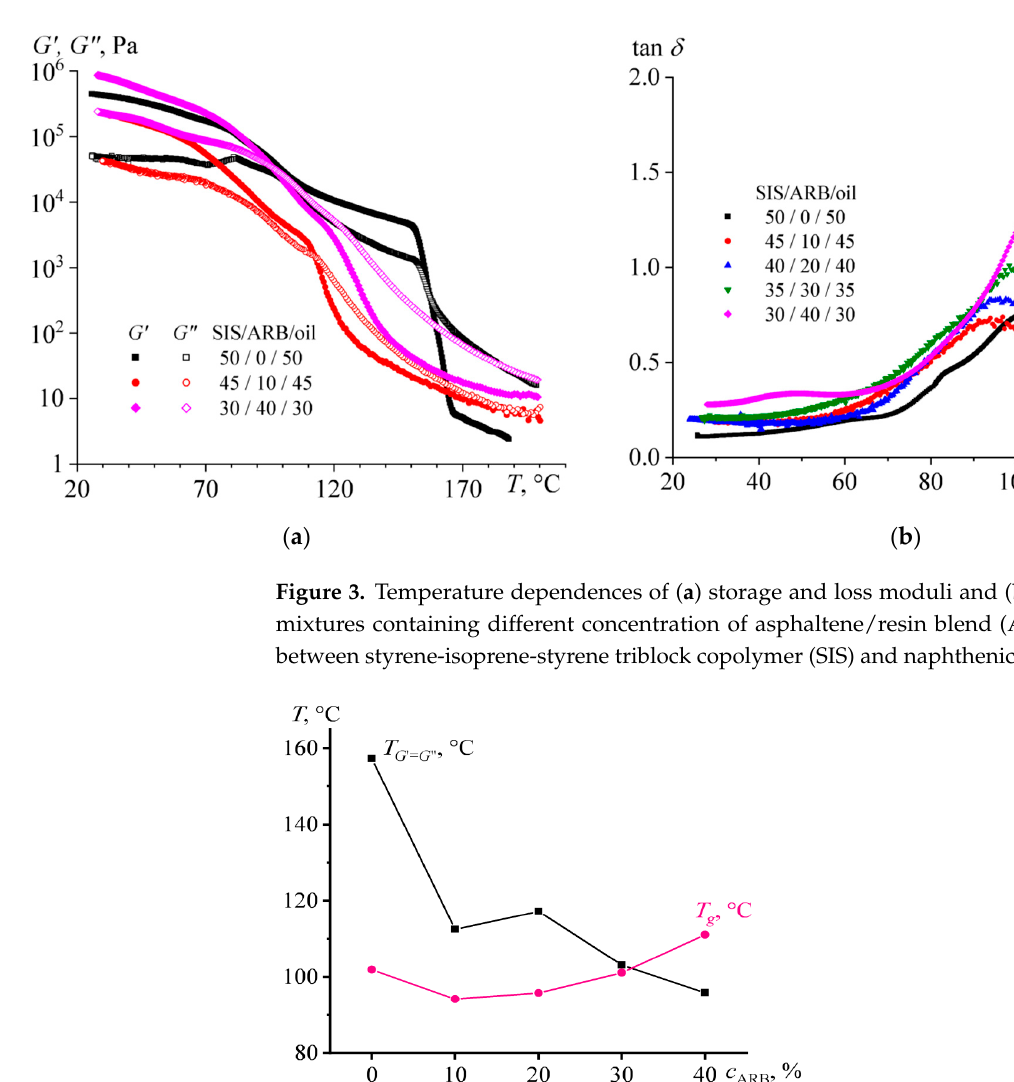
Figure 4. Concentration dependences of glass transition temperature and liquid–solid transition point for mixtures with different concentrations of asphaltene/resin blend (ARB) and an equal ratio between styrene ‐ isoprene ‐ styrene triblock copolymer and naphthenic oil.